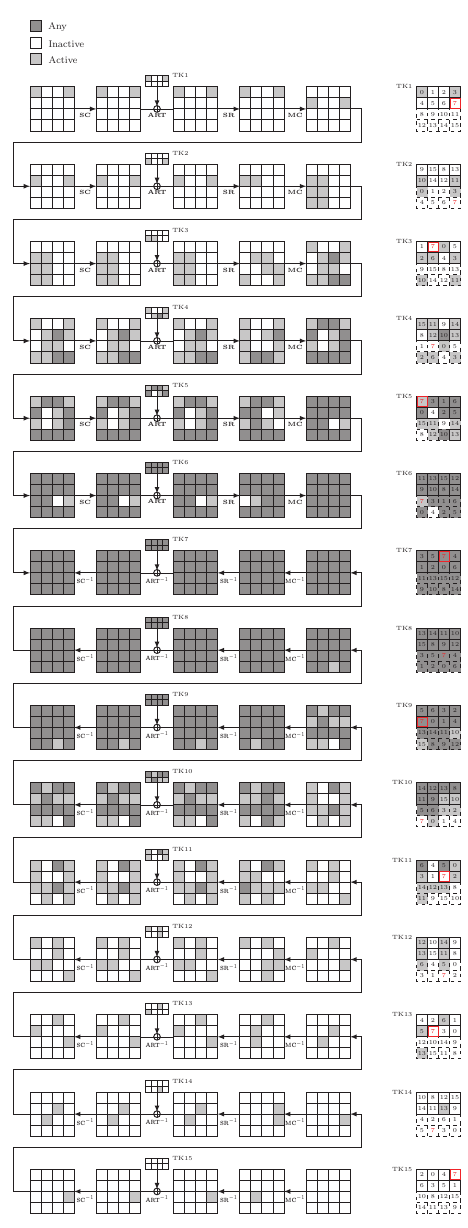
Figure 21: Zero-correlation linear hull for Skinny